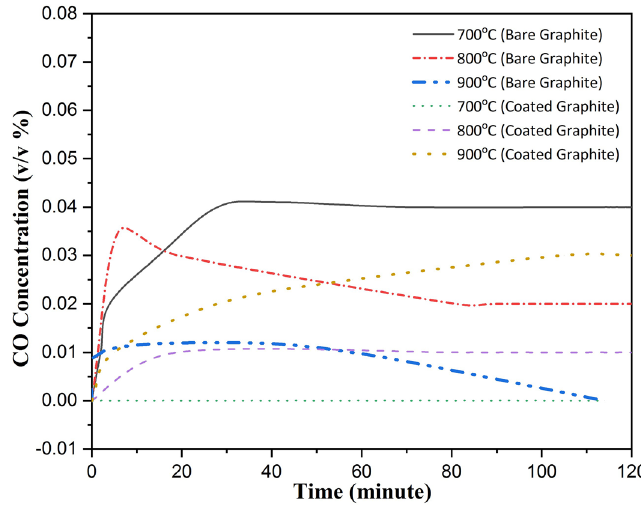
Figure 5. CO generation at different temperatures for bare and Al 2 O 3 coated graphite.